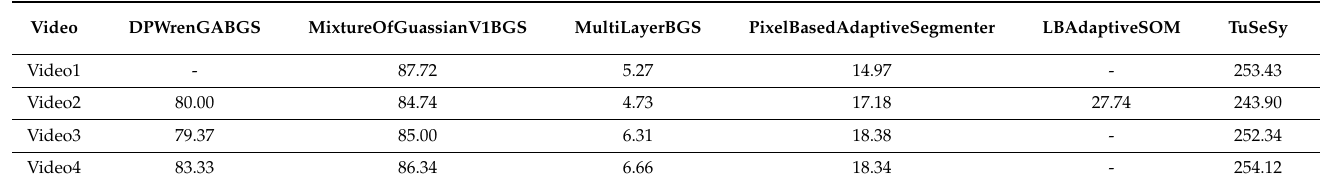
Table 2. FPS of all measures (‘-’ represents failure in obtaining the result).